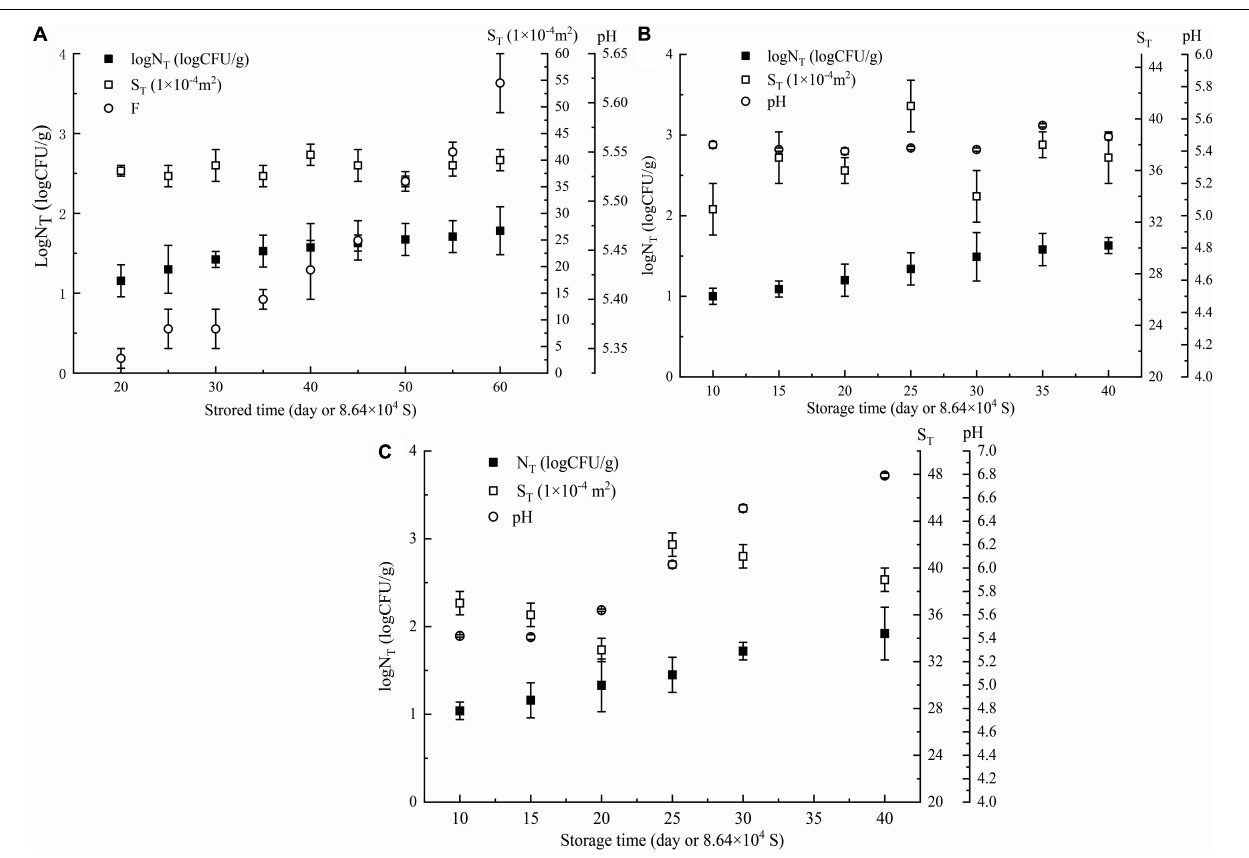
FIGURE 5 | External data: parameters of NGB (log N T , S T , storage time, and pH) obtained at different θ , (A) θ = 278 K, (B) θ = 283 K, (C) θ = 288 K. N T means observed Pseudomonas number (CFU/g). Error bars represent the standard deviation of three independent samples.